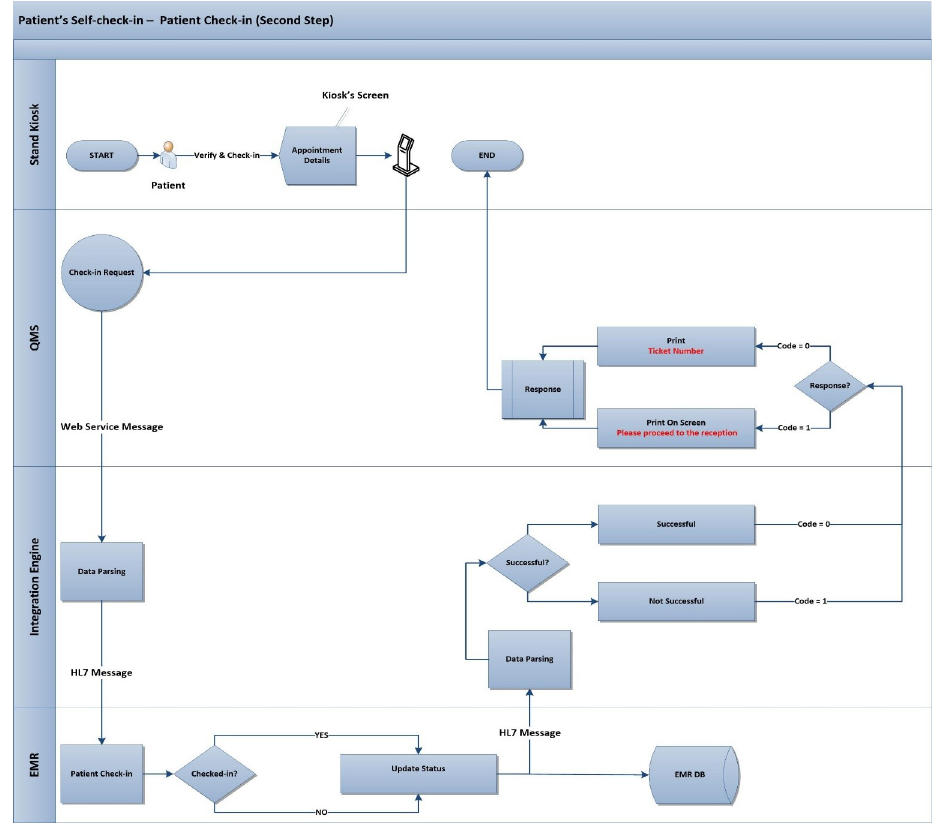
Fig 2. Second step—Patient